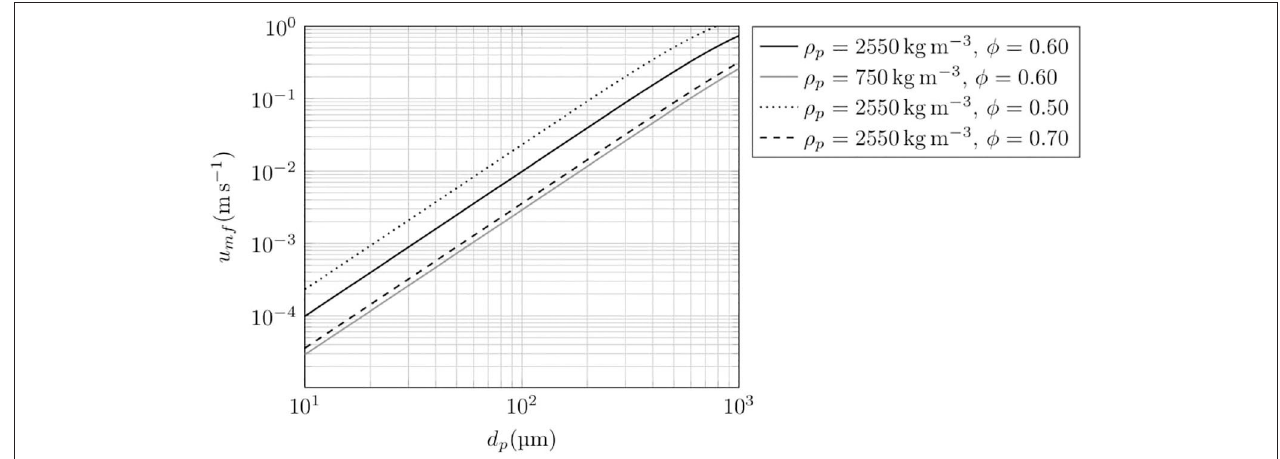
FIGURE 12 | Typical minimum fluidisation curves with particle diameter calculated from Equation (5) showing their sensitivity to particle density and particle volume fraction. The fluidising gas is superheated water vapour with a temperature of 250 ◦ C: ρ = 2.37 kg/m 3 and µ = 1.80 × 10 − 5